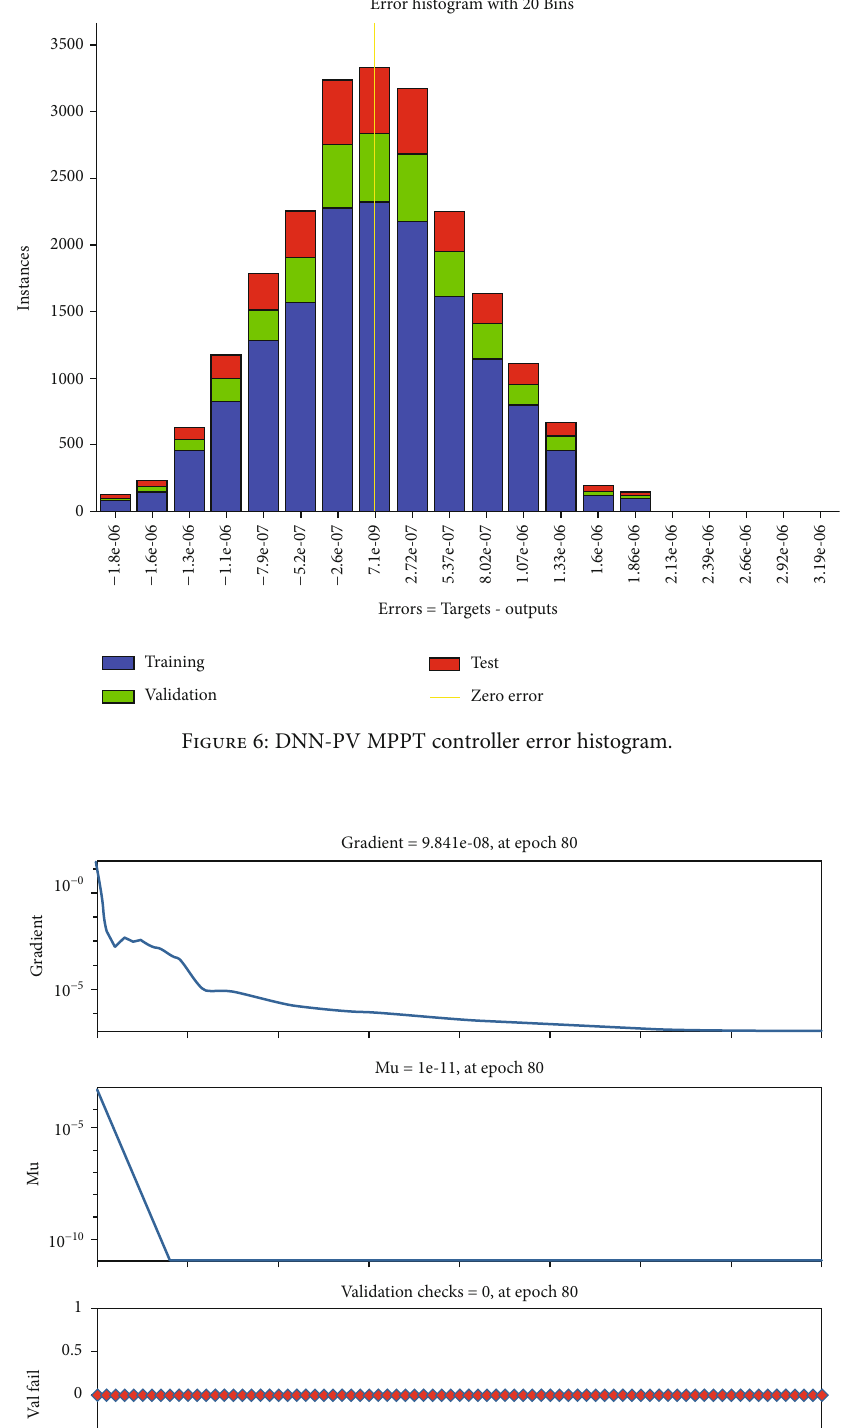
Validation checks = 0, at epoch 80